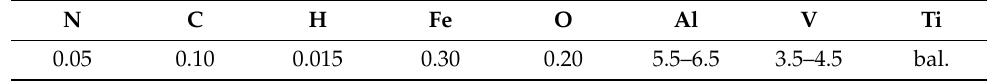
Table 1. Chemical Composition (in wt.